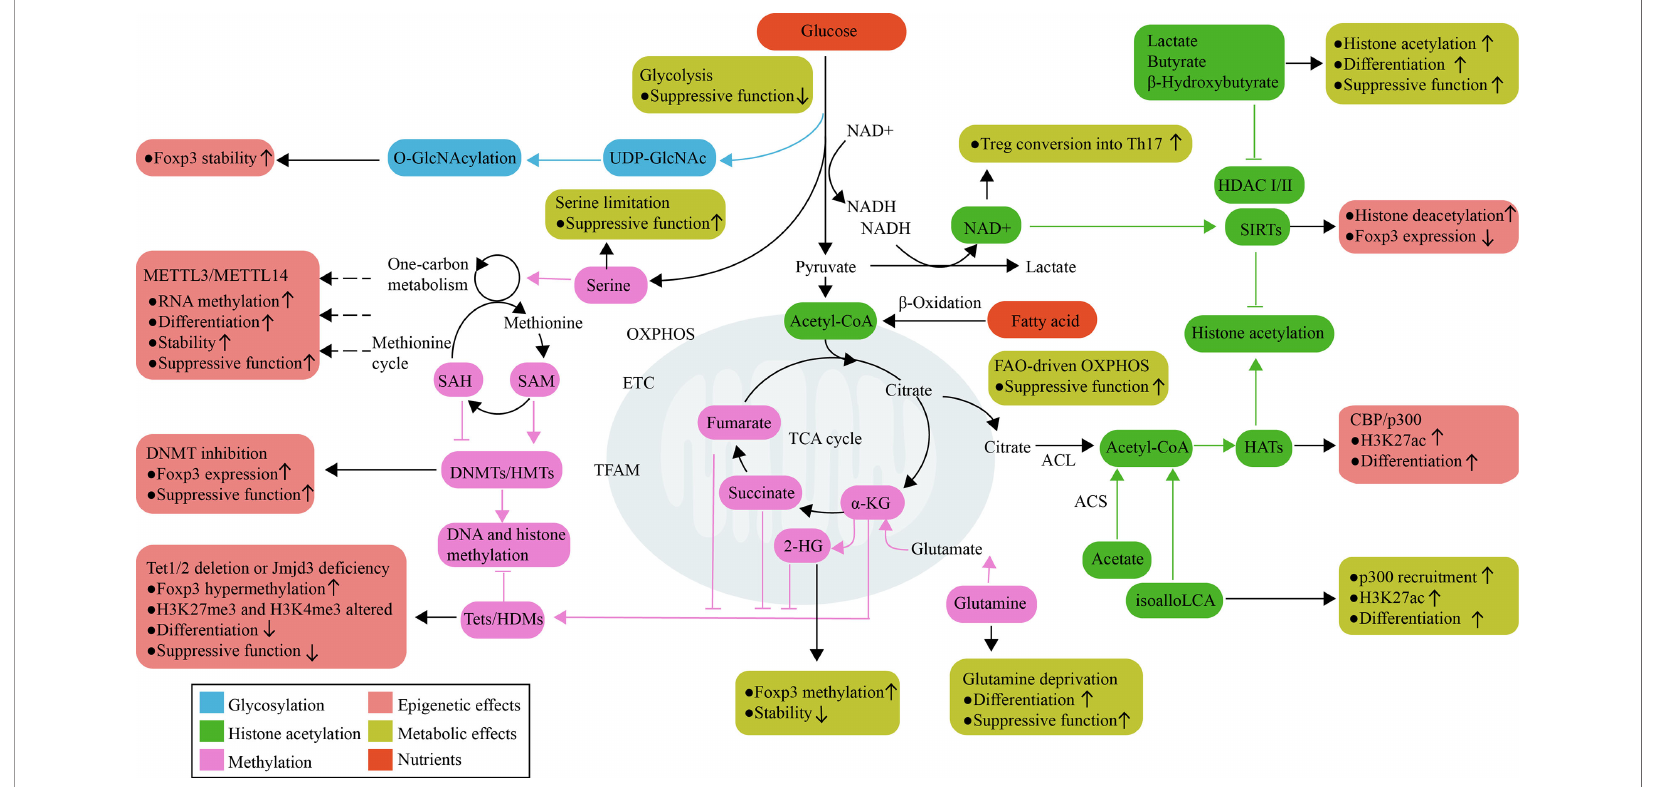
FIGURE 2 | Metabolic control of epigenetics in Treg cells. Treg cell activation, differentiation, and function are linked to metabolic reprogramming. Metabolic pathways not only process nutrients to produce ATP and meet energy requirements, but also use available metabolites as subtracts and cofactors for epigenetic enzymes that control Treg cell development. Glucose and glutamine are used to fuel O-GlcNAcylation, which can stabilize Foxp3. The mitochondria-derived metabolites a -KG, 2-HG, succinate, and fumarate are important for the function of DNA and histone demethylases; their effects oppose the actions of HMTs and DNMTs, which are regulated by amino acids that initiate one-carbon metabolism pathways and the methionine cycle. Histone acetylation is dependent on the supply of acetyl-CoA, which can be generated through a range of metabolic pathways. The product of bacterial anaerobic fermentation butyrate, as an inhibitor of HDACs, increases histone H3 acetylation in the Foxp3 locus and promotes Treg cell function. The SIRT family of enzymes promotes deacetylation function, which is dependent on NAD + availability as a cofactor and regulated by the NAD + /NADH ratio. RNA methylation also requires the transfer of a methyl group; however, the contribution of metabolites to RNA methylation has not yet been explored in Treg cells. 2-HG, 2-hydroxyglutarate; a -KG, a -ketoglutarate; ACL, ATP-citrate lyase; ACS, acetyl-CoA synthetase; DNMTs, DNA methyltransferases; ETC, electron transport chain; GlcNAc, N-acetylglucosamine; HATs, Histone acetyltransferase; HDMs, histone demethylases; HMTs, histone methyltransferases; OXPHOS, oxidative phosphorylation; SAH, S-adenosylhomocysteine; SAM, S-adenosylmethionine; SCFAs, short-chain fatty acids; SIRT, sirtuin; TCA, tricarboxylic acid; Tets, ten-eleven translocation family